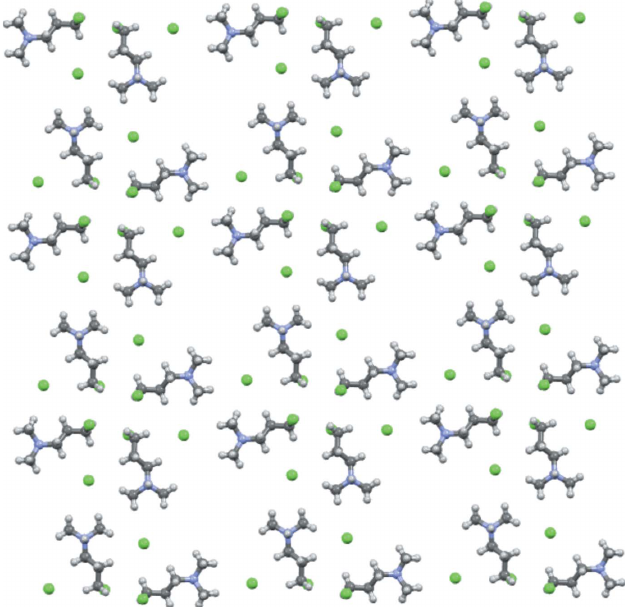
Figure 3 Ball-and-stick diagram of a portion of the layer in the ab plane. The three- dimensional structure is generated by offset stacking of these layers in the c -axis direction.